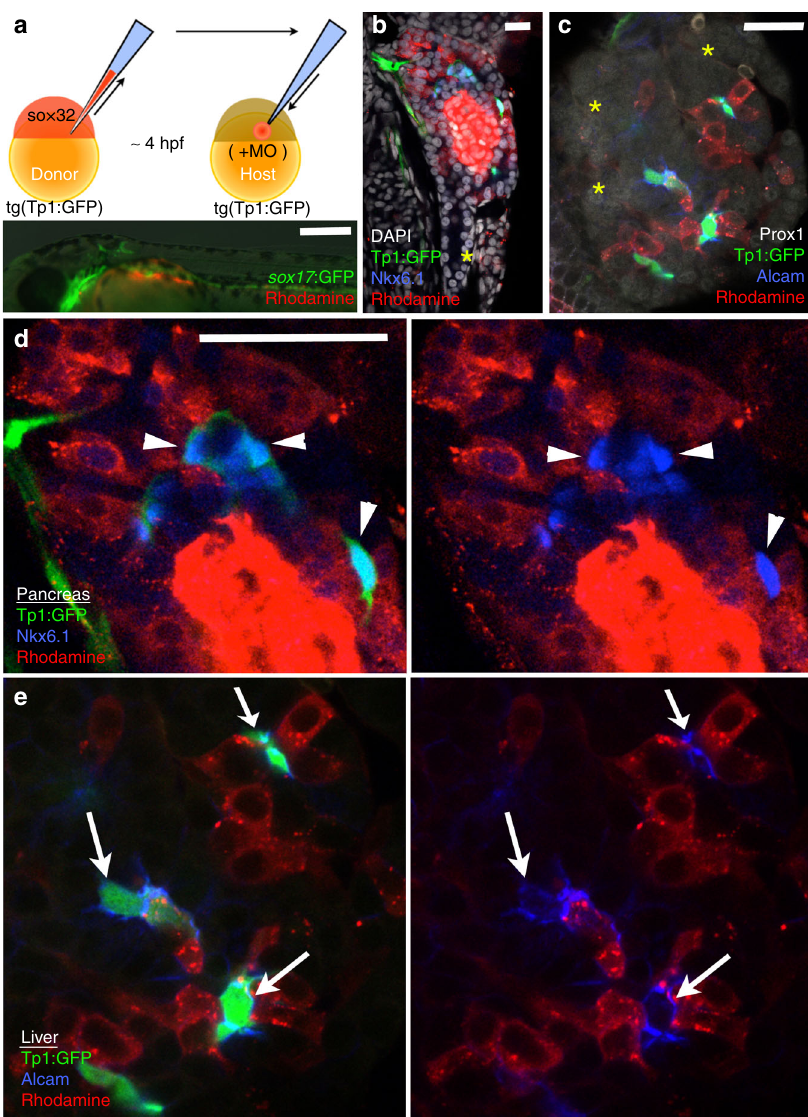
Fig. 5 Endoderm expression of Jagged induces Notch activity and lineage speci fi cation. a Schematic of transplant approach to generate endoderm chimeras. At the one-cell stage, wild type Tp1:GFP donor embryos were injected with rhodamine dextran for lineage tracing and sox32 mRNA for conversion to endoderm. At late blastula stage, donor cells were transplanted into Tp1:GFP host embryos that had been injected with antisense MO ’ s to knockdown Jag1a and Jag1b. ( a , bottom panel ) Example of endoderm chimeric embryo demonstrating rhodamine dextran labeled donor cells ( red ) localized primarily to the sox17 :GFP + ( green ) host gut endoderm region. b , c Immuno fl uorescence analysis of chimeric host pancreas ( b ) and liver ( c ) generated by the approach described in a demonstrating a rescue of Notch signaling in Jag1b/Jag2b compromised embryos by endoderm cells with wild type expression of Jag1b/Jag2b. Tp1:GFP + cells ( green ) are only observed in regions of these organs with wild type donor cells ( red ) but not in regions without donor cells ( yellow asterisks ), ( d , e ) (representative samples, n = 10 embryos. Samples pooled from 2 experiments). Rescued Tp1:GFP + cells found without rhodamine dextran ( red , white arrows and arrowhead ), are always directly associated with rhodamine dextran + cells. All rescued Tp1:GFP + host cells are Nkx6.1 + ( blue ) in the pancreas ( d ) and Alcama + ( blue ) in the liver ( e ), indicating that they are of the duct lineage. Scale bars 250 μ M a , and 25 μ M ( b – e